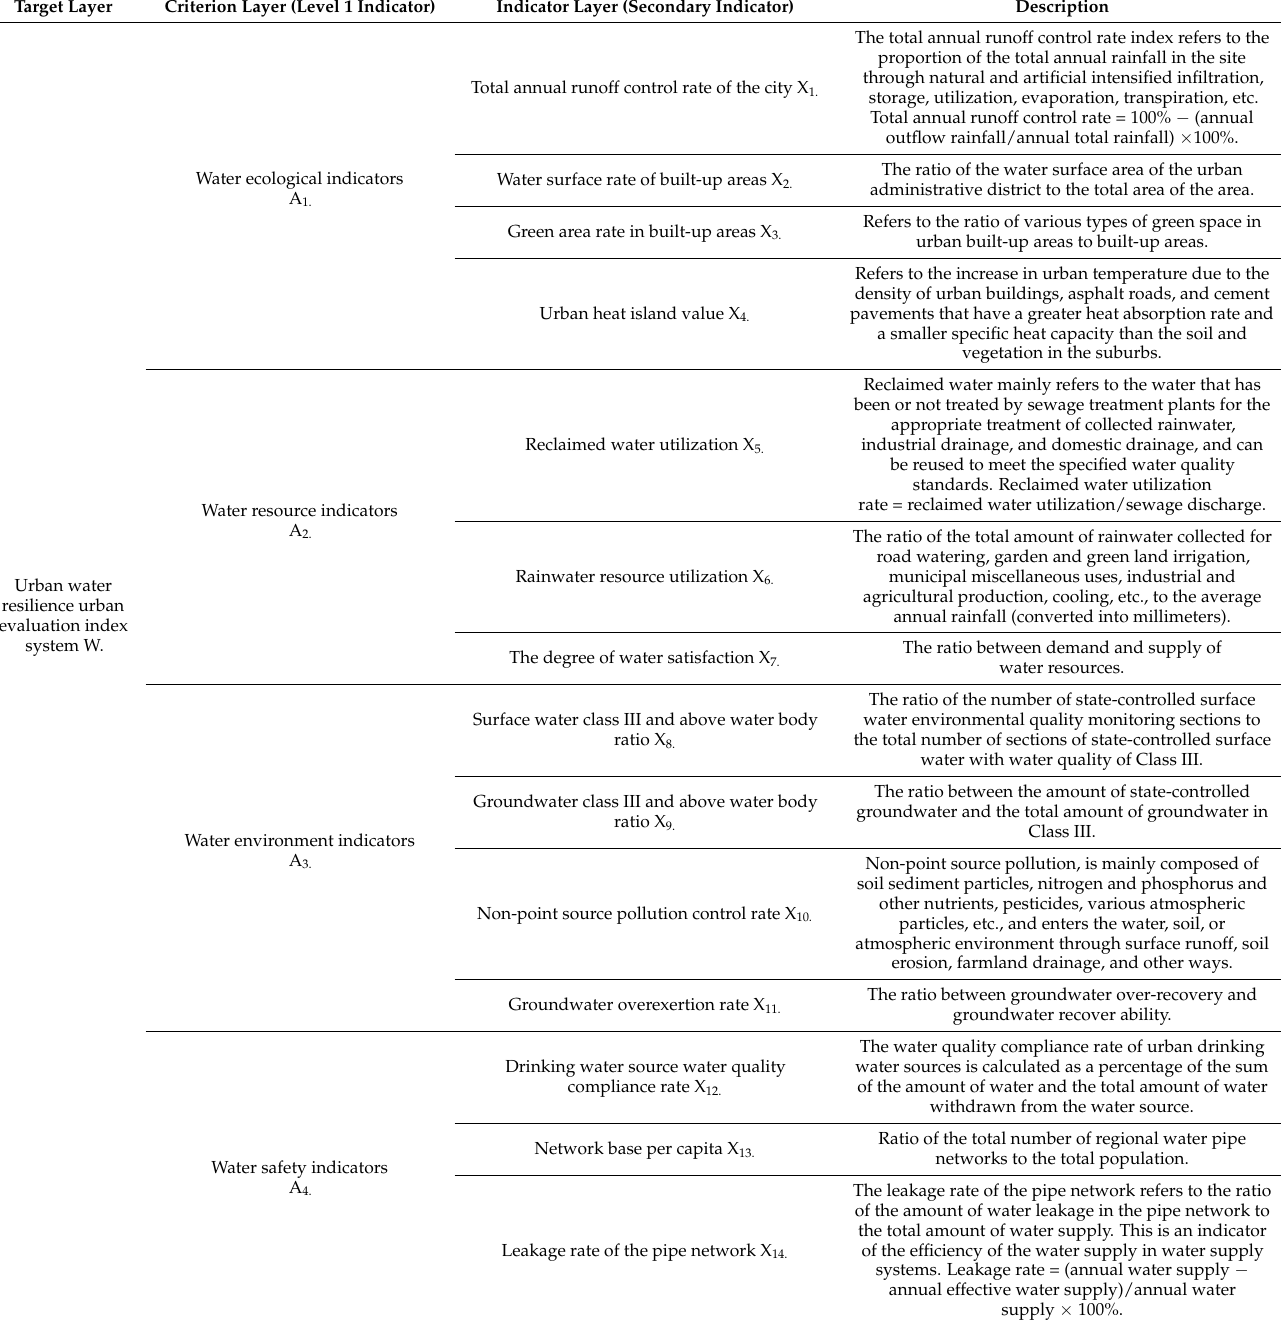
Table 1. Evaluation indicators of urban water